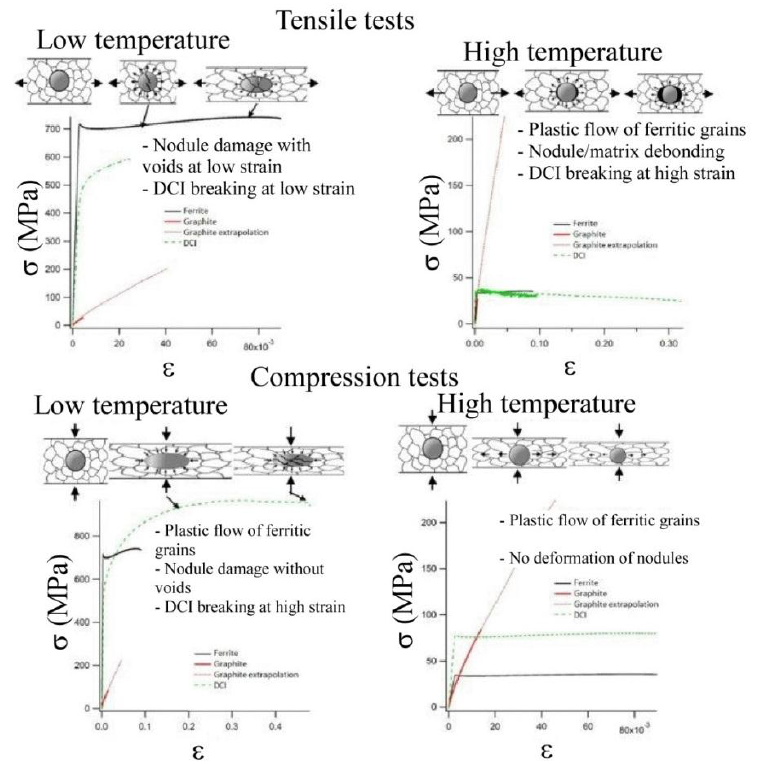
Figure 10. Overview of the damage mechanisms within and around graphite nodules. Low temperature refers to T < 673 K, typically. These mechanisms depend on the ferrite and the graphite mechanical properties, the temperature and the stress state (tensile and compression